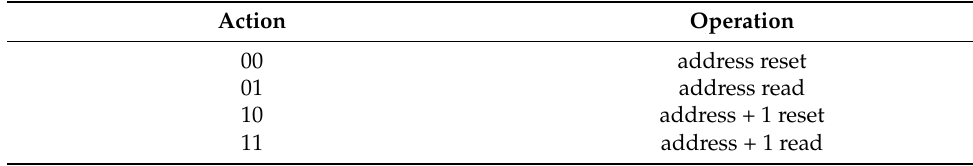
Table 2. Data output in STD mode.